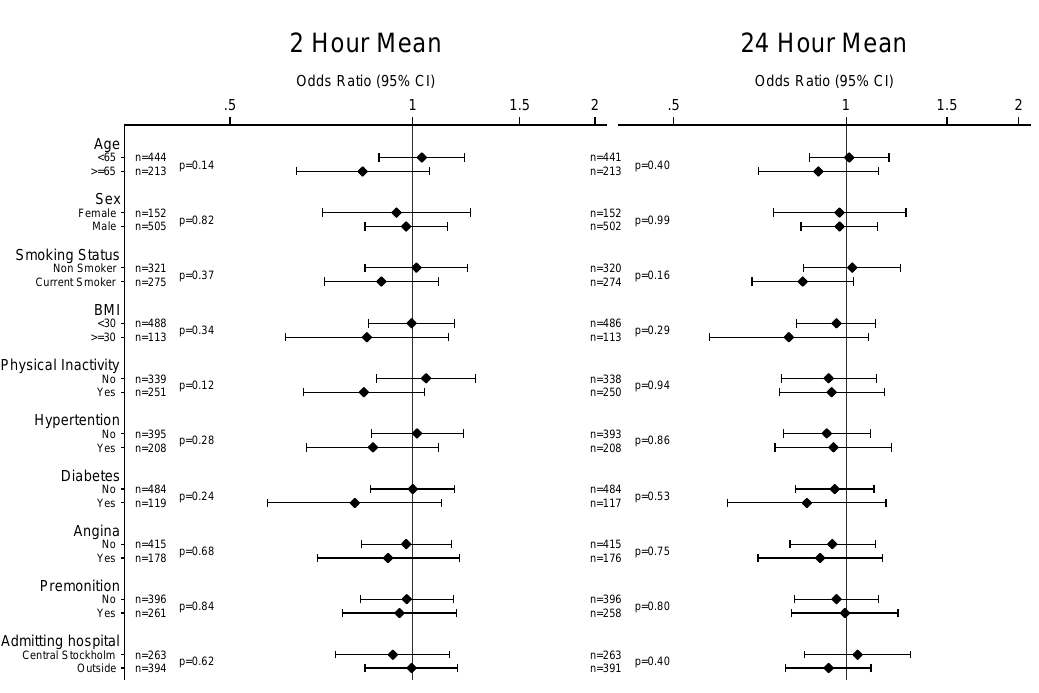
Figure 2. Odds ratios of myocardial infarction for an interquartile range increase in 2 h and 24 h moving averages of NO in different subgroups (P-values for interaction). Number of 2 observations for each subgroup with complete data on analyzed covariate and air pollution indicated by n.